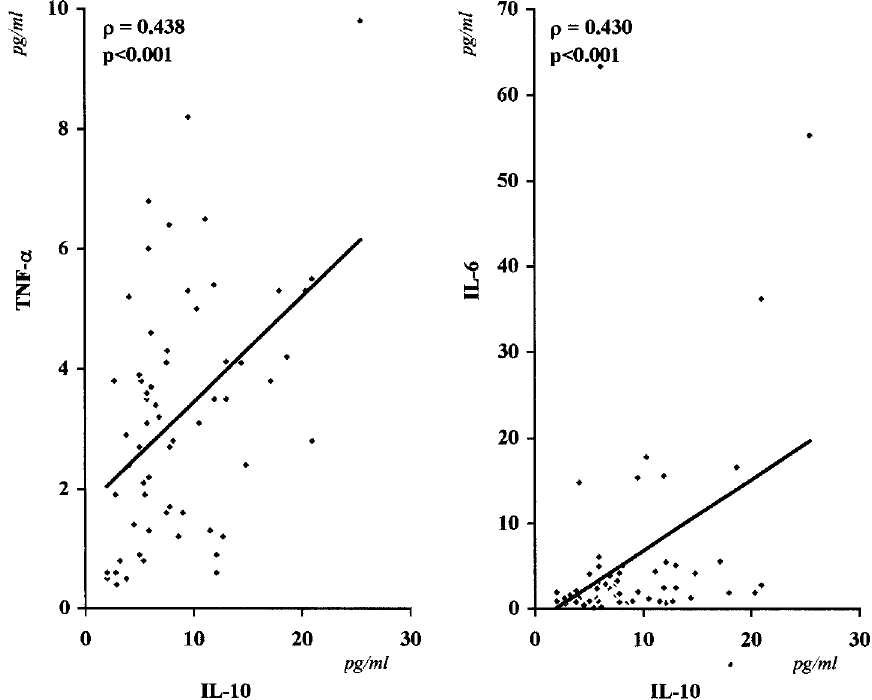
FIG. 2. Correlations between IL-10 and TNF- a and between IL-10 and IL-6 serum concentrations in patients with